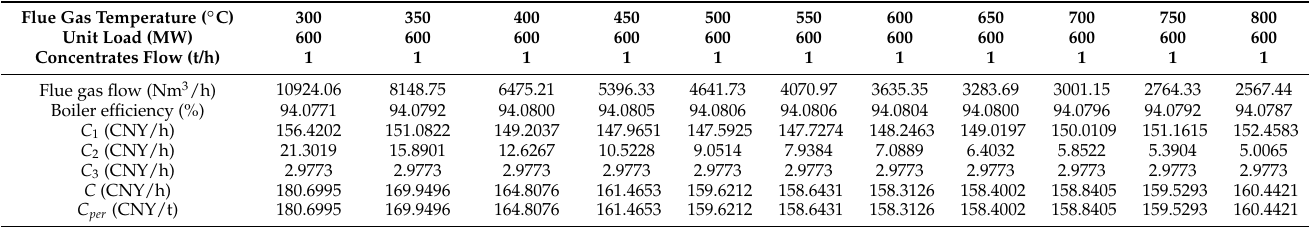
Table 2. Economic parameters under different extracted flue gas temperature operating conditions.